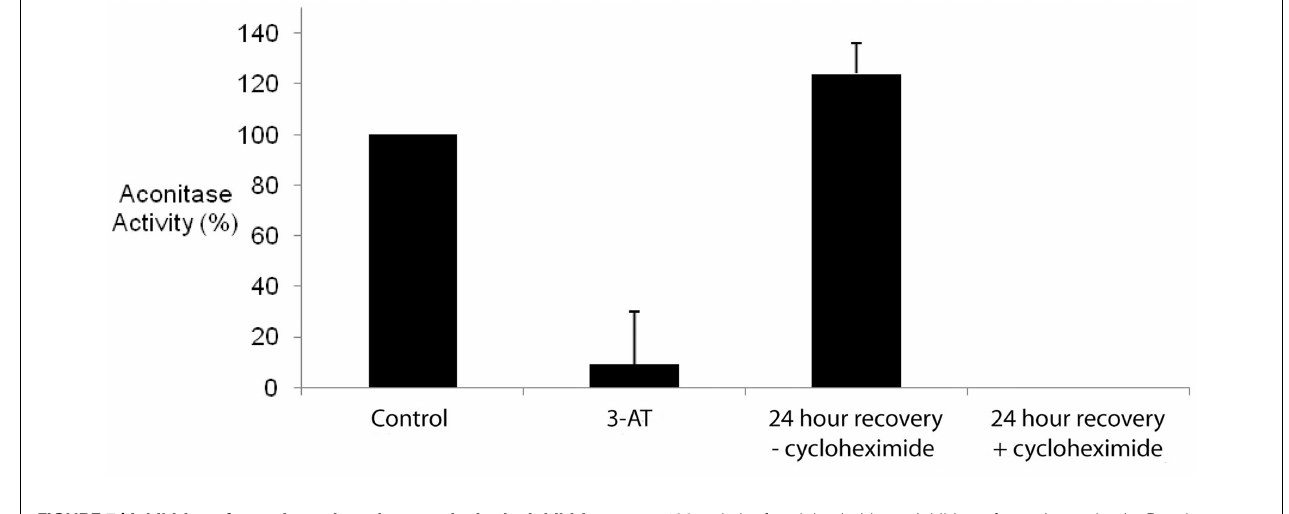
100 μ g/mL of cycloheximide, an inhibitor of protein synthesis. Results indicate the inhibition of the peroxisomal antioxidant enzyme, catalase, results in significant inhibition of the oxidatively sensitive mitochondrial enzyme, aconitase ( p < 0.05).While aconitase activity recovers following the removal of 3-AT, this activity fails to recover and was undetectable in the presence of cycloheximide.